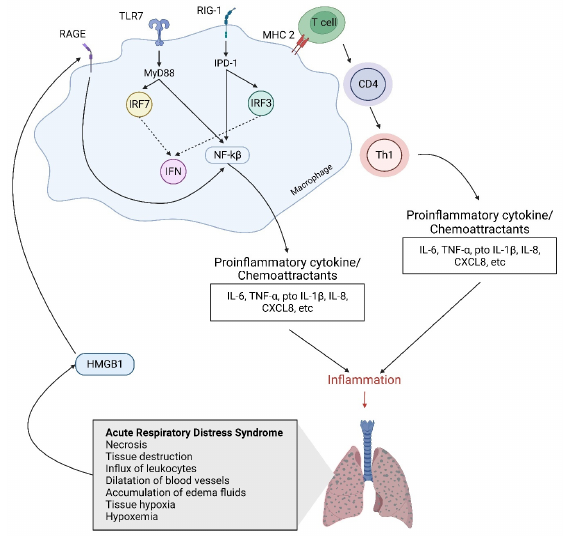
Figure 1. Cytokine Storm and ALI/ARDS Induced by Influenza Virus Infection. When a highly pathogenic influenza A virus infects alveolar epithelial cells, macrophages recognize this virus using TLR 7, which involves several adaptor molecules and transcription factors, such as MyD88, and activates IRF7 and NF- κ B. Influenza A virus can also be recognized by RIG 1 via the adaptor molecule IPD-I and activate IRF3 and NF- κ B. The activation of IRF-7 and IRF-3 causes their translocation into the nucleus. This produces interferon type I, while NF- κ B acts as a transcription factor to induce pro-inflammatory cytokines’ production, including IL-6, TNF α , and pro-IL-1 β . Macrophages also present virus peptides on the cell surface through MHC class II and activate lymphocyte CD4 T cells, which differentiate into Th1. Activated lymphocyte T cells then release various pro-inflammatory cytokines and chemoattractants. All of these mechanisms result in a cytokine storm. The cytokine storm then leads to ARDS, characterized by necrosis, tissue damage, an influx of leucocytes, and blood vessel dilation, causing edema fluids to accumulate in the alveolar, characterized by tissue hypoxia and hypoxemia. The damaged tissue releases HMGB1 and binds with RAGE, activating the intracellular signaling pathway and resulting in NF- κ B activation and pro-inflammatory